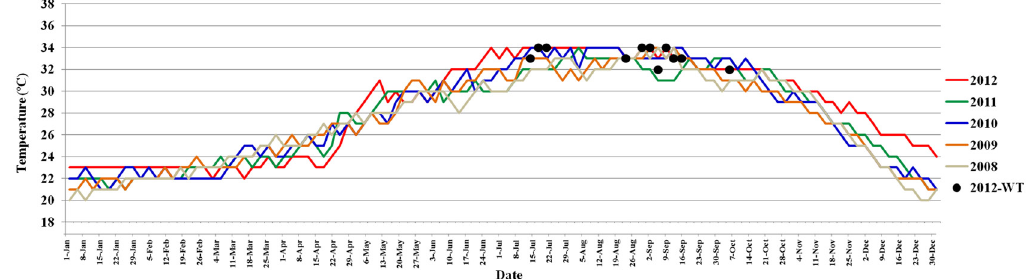
Fig. 2. – Multi-year sea surface temperatures in the study area. Water temperatures recorded by dive computers during the study are shown as